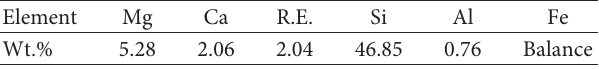
Table 2: Chemical composition of the inoculant. Table 3: Chemical composition of the spheroidizer.